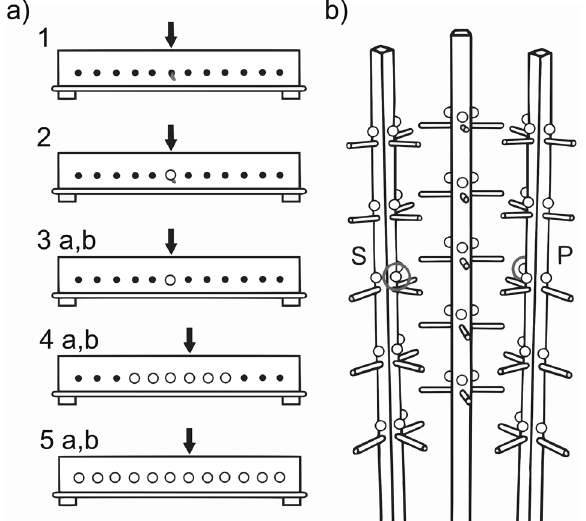
Figure 1. ( a ) The 5 Motor Training Stages (8 stages total) as they appeared on the training board. The black dots represent empty holes. The white dots represent holes covered by white, acrylic 0.5 inch pompoms. The arrows denote the location of the mealworm ( Tenebrio molitor ) reward. The mealworm reward is pictured uncovered in Stage 1, half covered in Stage 2, and completely covered by a pompom after Stage 3. In each of the stages, the bird had to consume the mealworm reward from the training panel to progress to the next stage. If it failed the stage (i.e., did not consume the meal worm within 15 min), it regressed to the previous stage. ( b ) Location of the mealworm reward during the spatial memory trials (S) and proactive interference trials (P). The location of the worm alternated sides across cages, and only one side is pictured here. It proceeded with the worm having no pompom over it (information stage 1). If the bird successfully retrieved the worm, another worm was placed in the hole (information stage 2–1) and two mealworms were placed in the hole if the initial worm was not retrieved (information stage 2–2). The bird continued onto information stage 3 if the mealworms were consumed or stayed at information stage 2–2 if they were not. For information stage 3, the bird retrieved a mealworm half covered by a pompom, then retrieved a mealworm completely covered by a single pompom for information stages 4–5. Every hole was covered with a pompom during the spatial memory and proactive interference